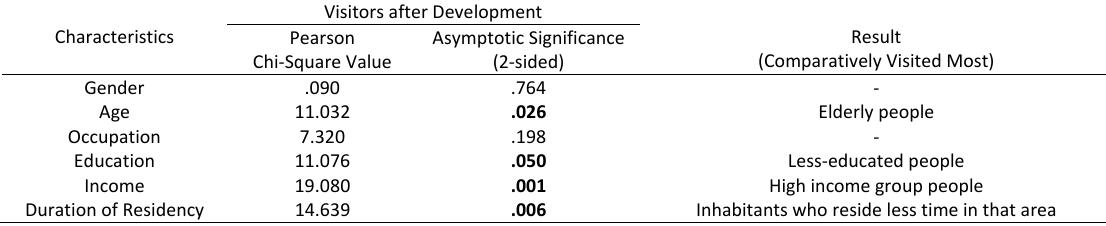
Table 3: Chi‐square analysis on association of demography with visitors after development Table 3: Chi-square analysis on association of demography with visitors after Fig. 4: Newly Installed Infrastructure Characteristics